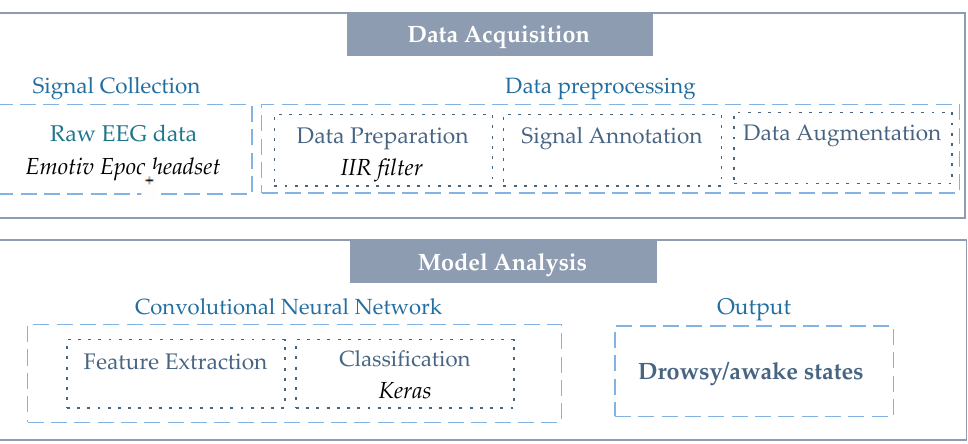
Figure 1. Pipeline of the proposed drowsiness detection (DD)